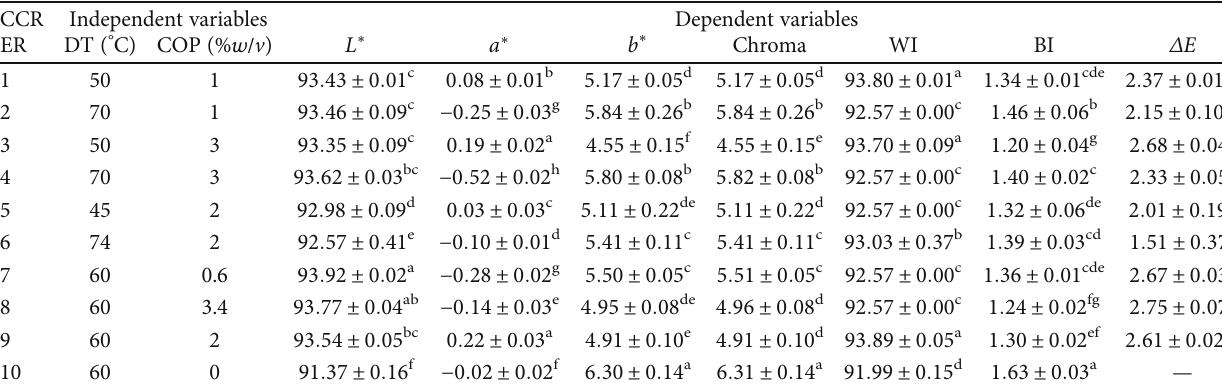
Table 4: Experimental runs and colour properties of cassava fl our (CCR) under di ff erent processing conditions. CCR Independent variables